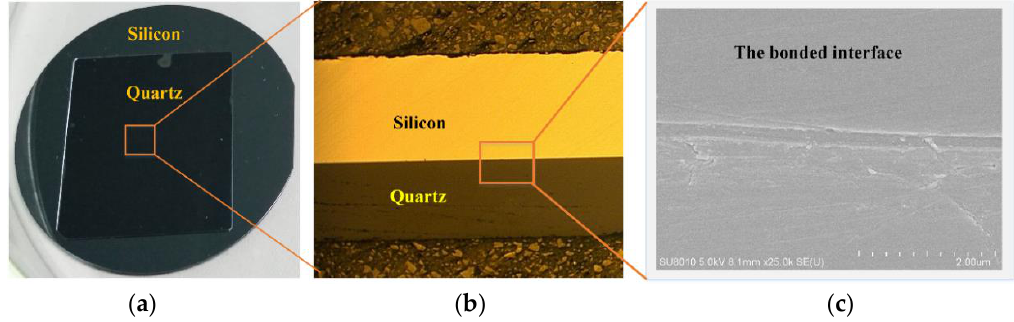
Figure 5. Photograph of quartz on silicon (QoS) via direct bonding: ( a ) the bonded wafer of quartz and silicon, ( b ) optical microscopy image of the cross-sectional view of QoS, and ( c ) SEM photograph of the cross-sectional view of QoS.